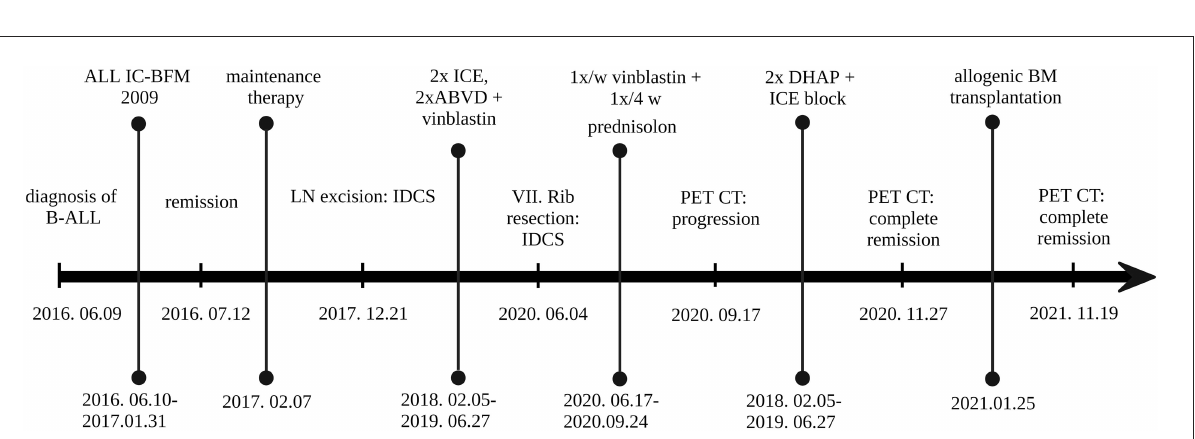
FIGURE2 Historical timeline of the case. ABVD, doxorubicin (Adriamycin), bleomycin, vinblastine, dacarbazine; B-ALL, B-lymphoblastic leukemia; BM, bone marrow; DHAP, dexamethasone, cytarabine (Ara C), cisplatin; ICE, infusional ifosfamide carboplatin, etoposide; LN, lymph node. Created with